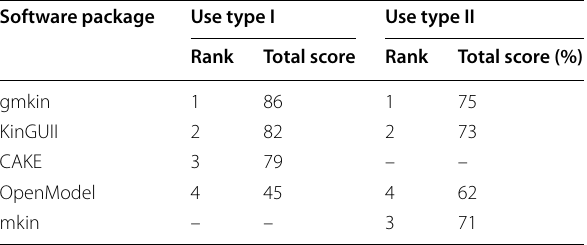
Table 3 Results of the final quantitative ranking of the preselected software packages Software